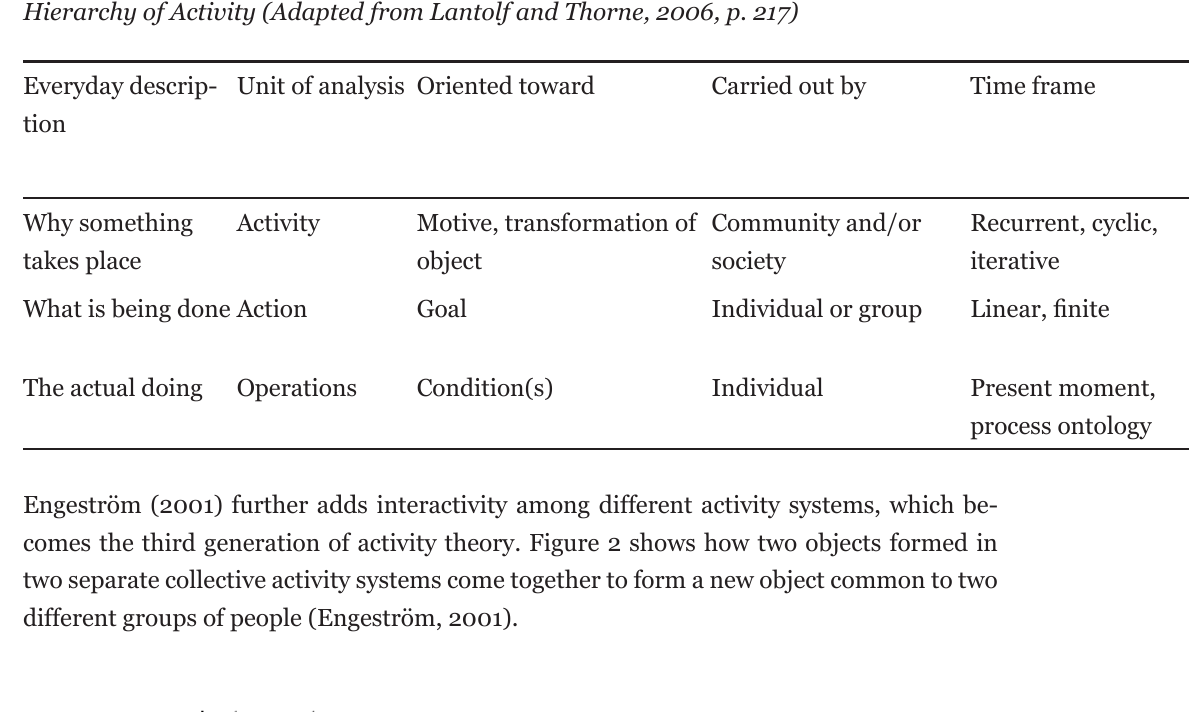
Hierarchy of Activity (Adapted from Lantolf and Thorne, 2006, p. 217)